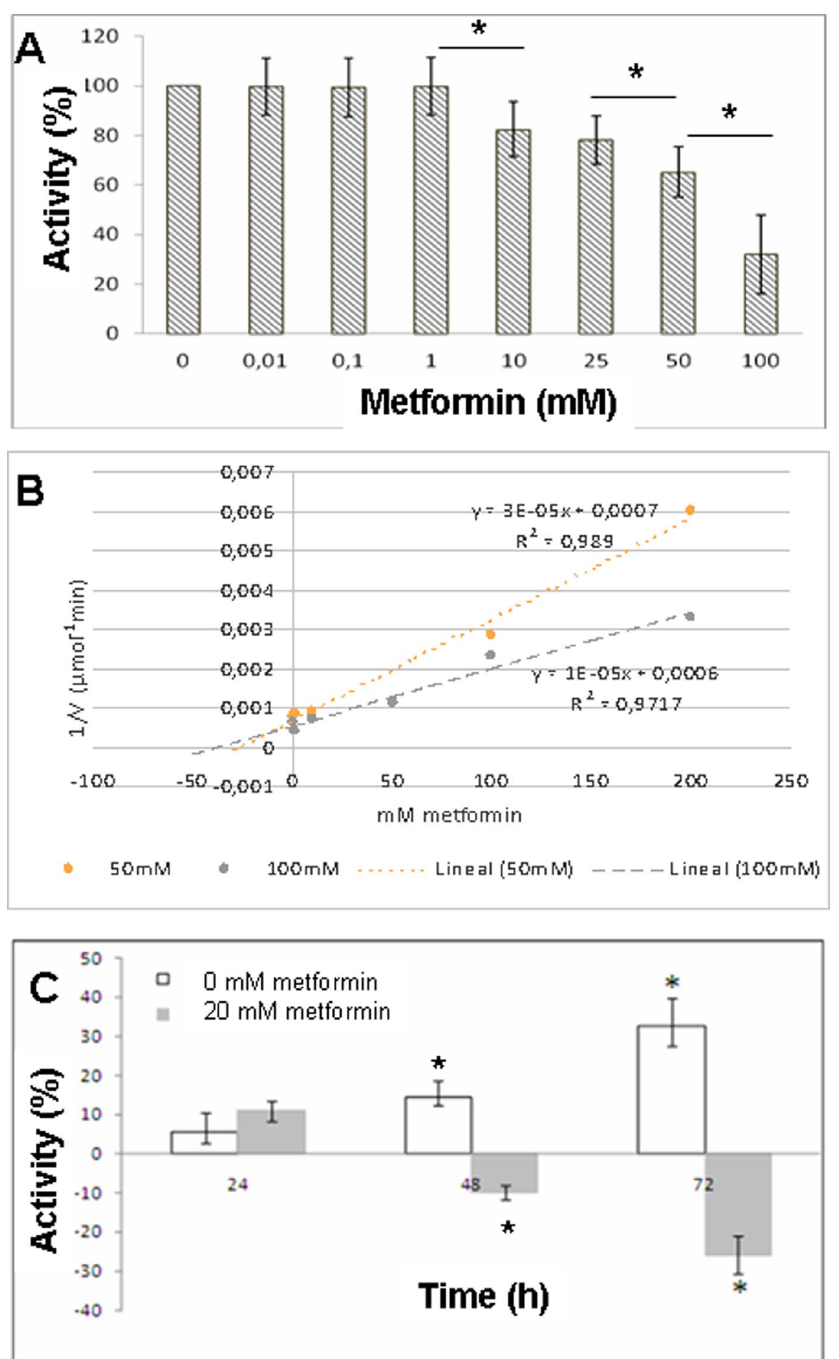
Figure 5. Metformin inhibits glutaminase activity in a dose dependent manner: from 17.5% at 10 mM up to 68% at 100 mM (A) (* p , 0.05). This effect, analyzed by Dixon plot, showed competitive inhibition kinetics, with a K i of 14.28 mM (B). In Caco2 cells, metformin 20 mM showed 24% inhibition of glutaminase activity at 72 hours compared to control cultures (p , 0.05) (glutamate production was decreased from 26.85 6 0.74 m M to 19.9 6 2.05 m M; p , 0.05) (C).